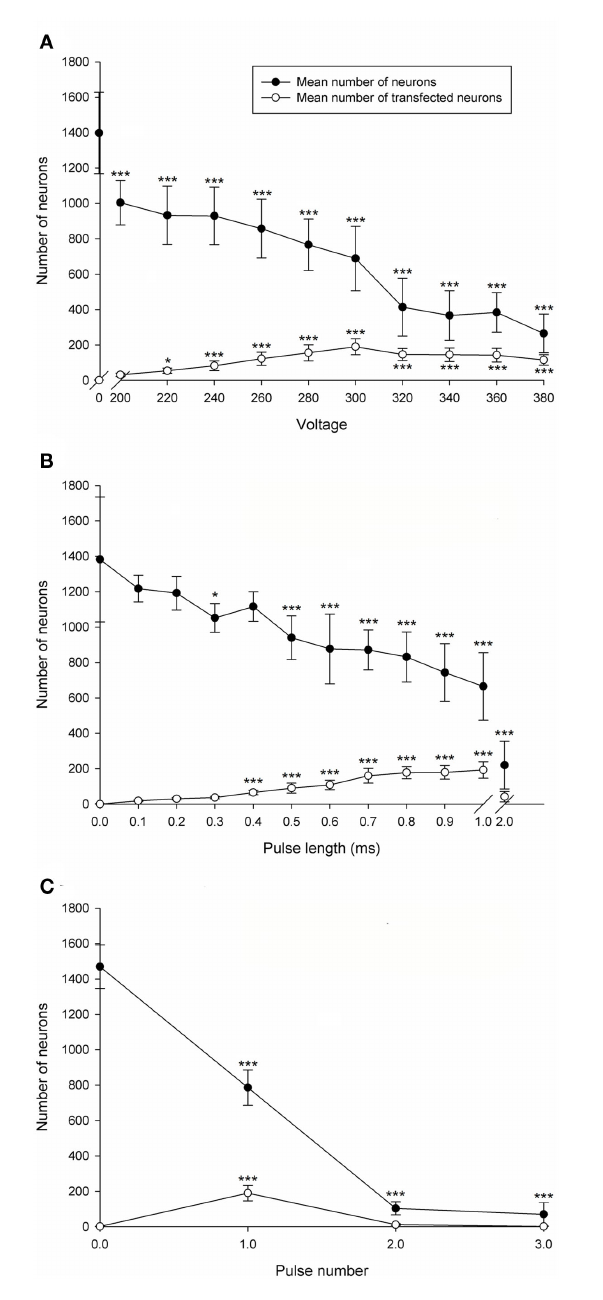
FIGURE 2 | Electroporation optimization of postnatal rat CGNs. (A) Voltage optimization.The mean number of CGNs was significantly decreased at all voltages compared to the non-electroporated control.The mean number of transfected CGNs significantly increased at voltages higher than 200V compared to the non-electroporated control. (B) Pulse length optimization.The mean number of CGNs was significantly decreased at pulse lengths higher than 0.4ms.The mean number of transfected CGNs significantly increased using pulse lengths between 0.4 and 1ms. (C) Pulse number optimization.The mean number of CGNs was significantly decreased at all pulse numbers.The mean number of transfected CGNs was significantly increased using 1 pulse.Values represent mean and SD; analysis was performed using one way ANOVA with Dunnett’s post hoc tests comparing with the non-electroporated control ( ∗ P < 0.05, ∗∗∗ P < 0.001), n =